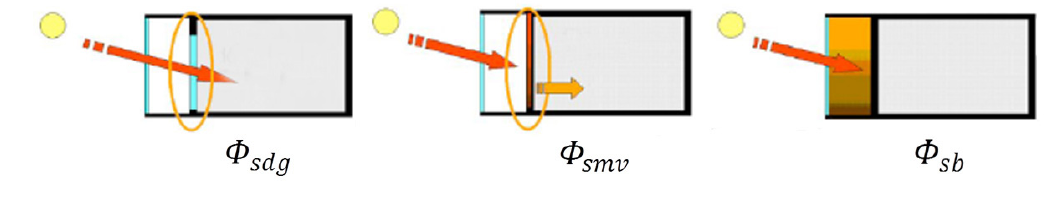
Figure 1. Solar contributions according to “Method